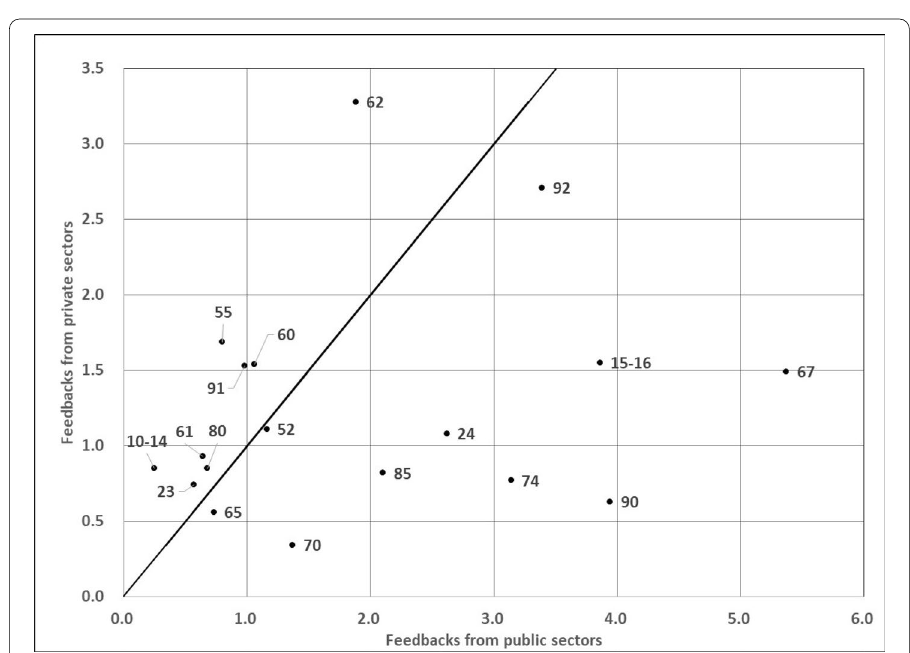
Fig. 1 Percentage feedback effects for each sector. Keys: 10–14, Mining and Quarrying; 15–16, Food, beverages and tobacco; 23, Petroleum; 24, Chemical products; 52, Retail trade; 55, Hotels and restaurants; 60, Land transport; 61, Water transport; 62, Air transport; 65, Financial intermediation; 67, Finance-related services; 70, Real estate activities; 74, Other business activities; 80, Education; 85, Health and social work; 90, Sewage and sanitation services; 91, Activities of membership organizations n.e.c; 92, Recreational, cultural and sporting